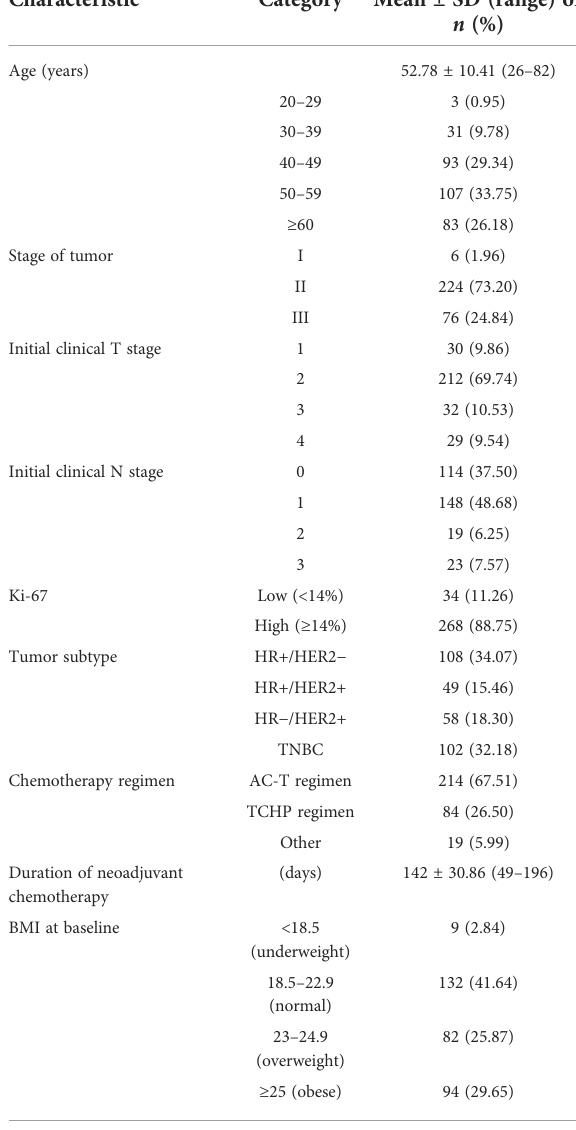
TABLE 1 Demographics and clinical characteristics of the sample ( N = 317).